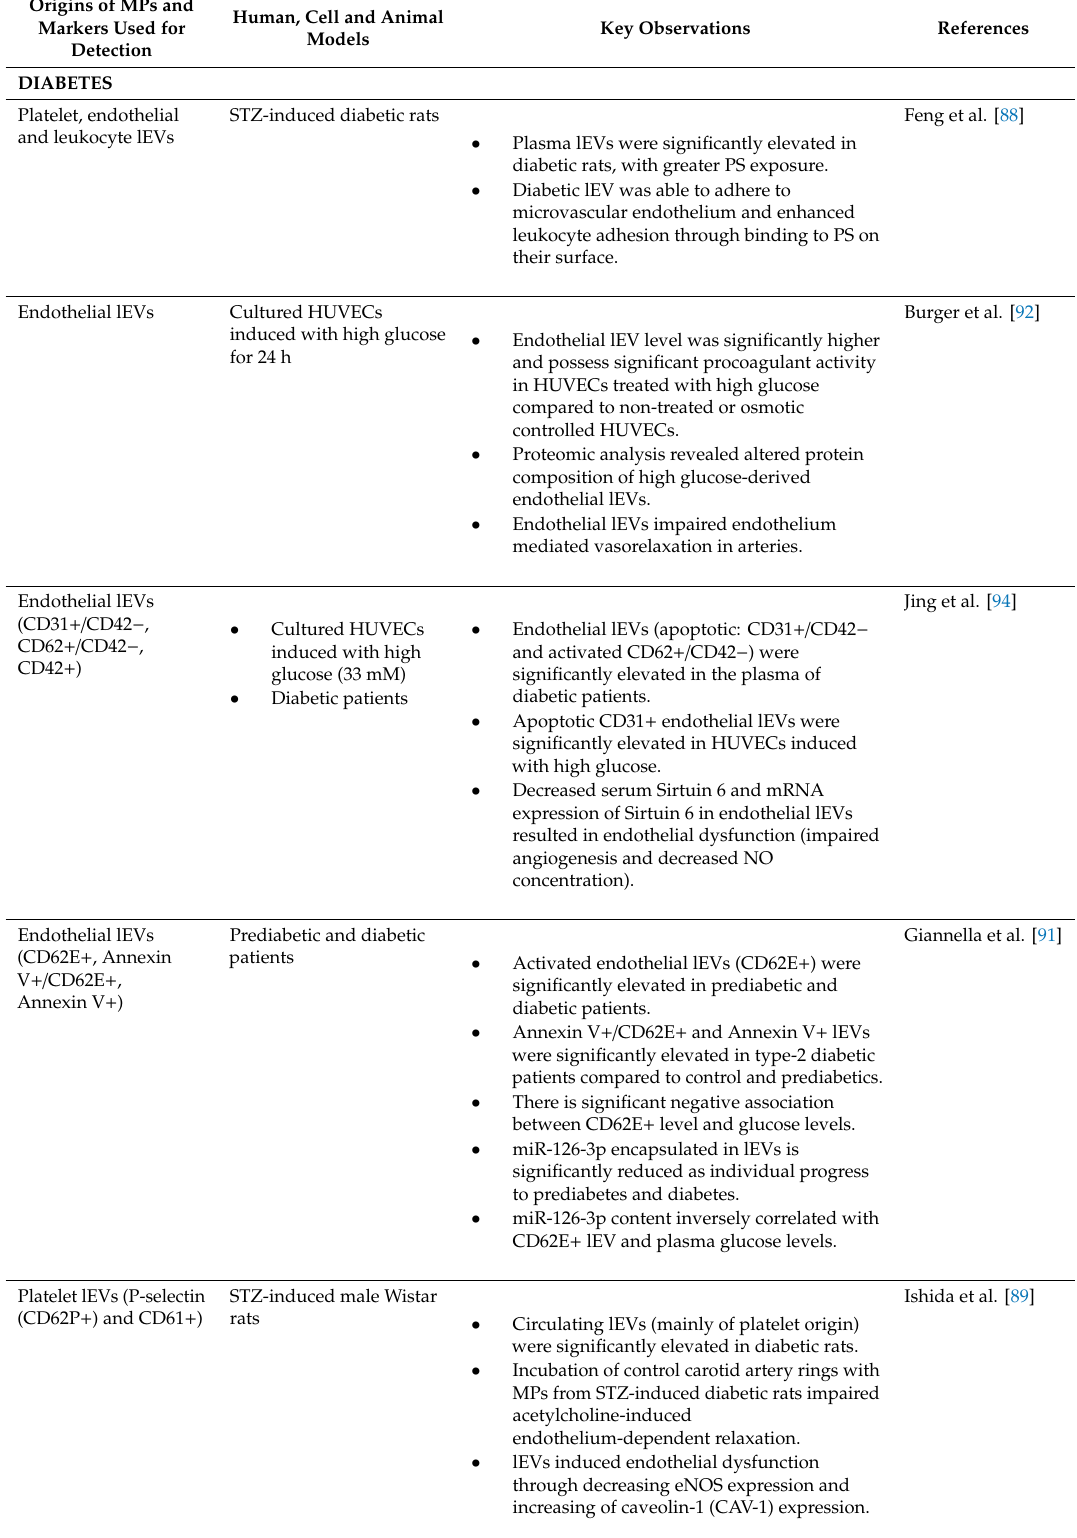
Table 3. Summary of the main studies of altered lEV (MP) levels and their associated e ff ects on diabetes in human, in vitro and animal